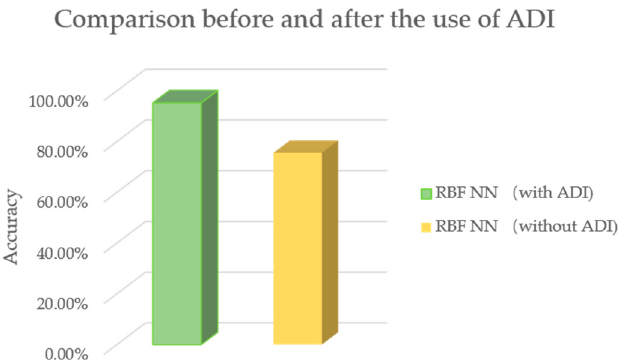
Figure 7. Comparisons results with or without ADI algorithm.